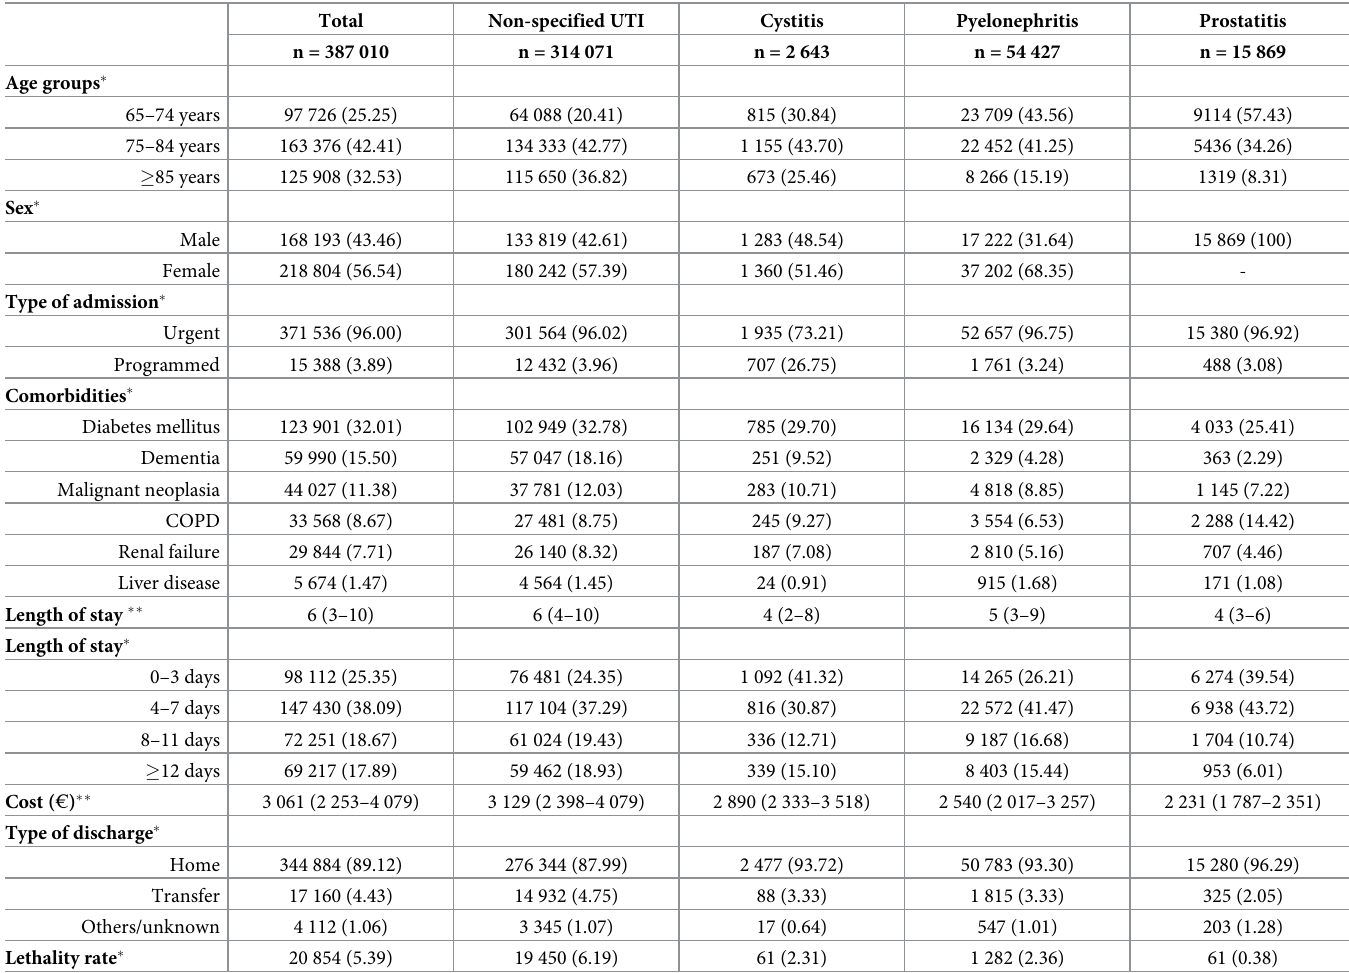
Table 1. Characteristics of urinary tract infection (globally and by different